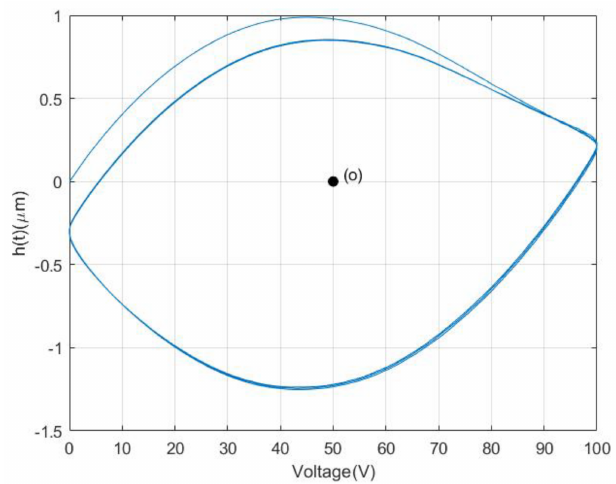
Figure 2. Nonlinear components of